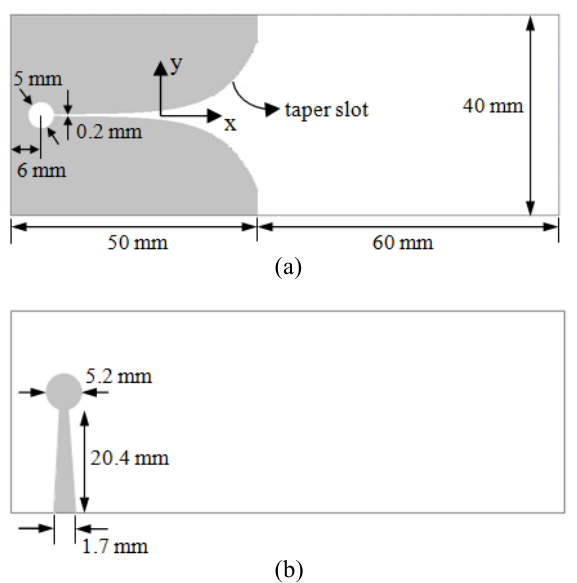
Figure 5: Geometry of the reference TSA, (a) Top view and, (b) Bottom view